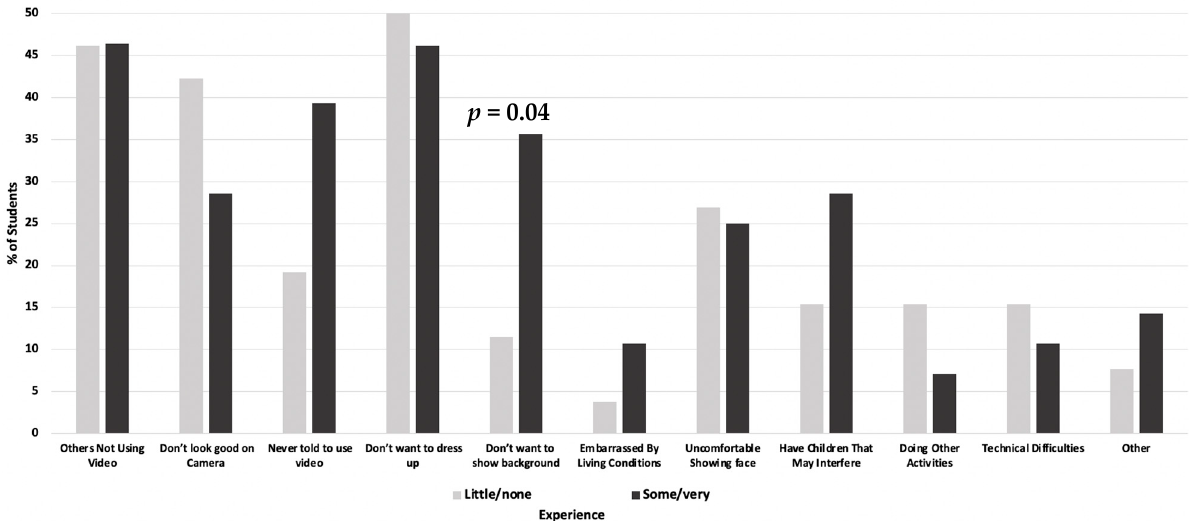
Figure 1. Comparisons of reasons for not using video by experience with video videoconferencing before March 2020 (N = 54). Comparisons performed with independent t -tests.